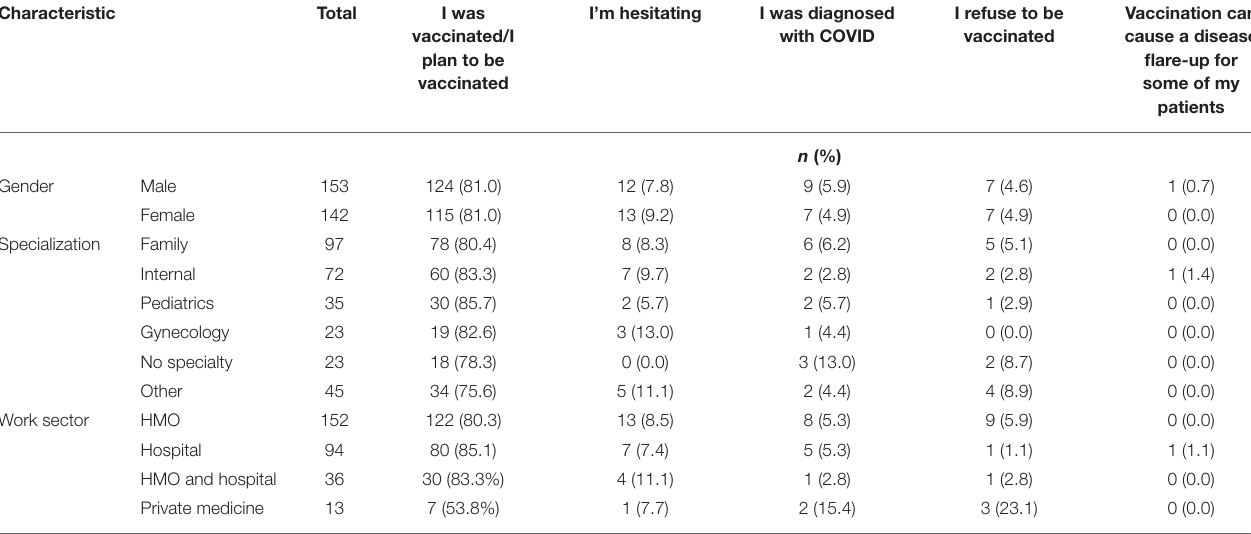
TABLE 2 | Physician’ vaccination decisions and associations between gender, specialization and work sector ( n = 295). Characteristic